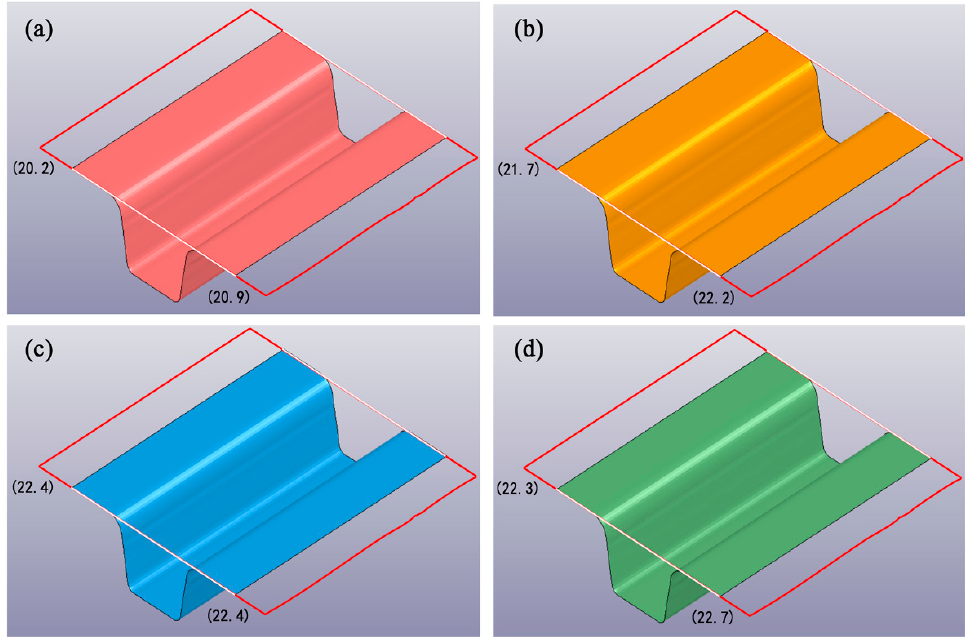
Figure 11. Material inflow of formed parts with different lubrication conditions (mm): ( a ) No lubricant; ( b ) Boron nitride lubricant; ( c ) Graphite lubricant; ( d ) Molybdenum disulfide lubricant.